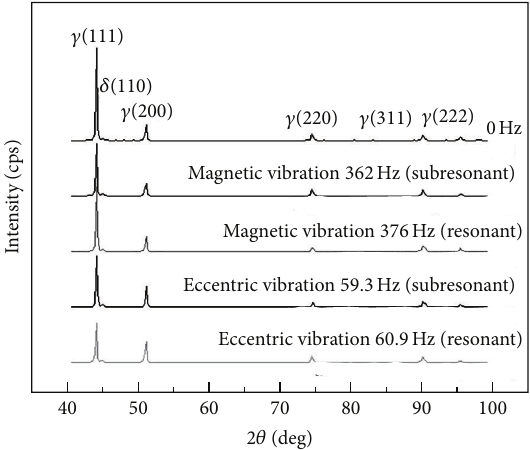
Figure 10: X-ray diffraction pattern of the welds with different vibration